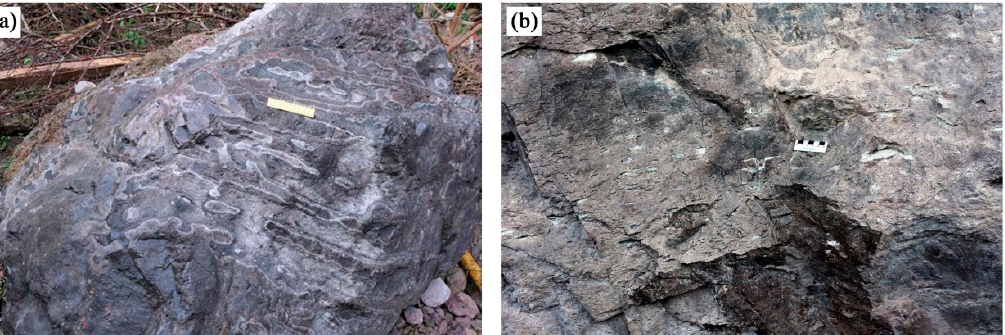
Figure 4. The welded tuffs of the Lower Cretaceous Jiuliping Formation. ( a ) The strongly welded tuff. ( b ) The weakly welded tuff.